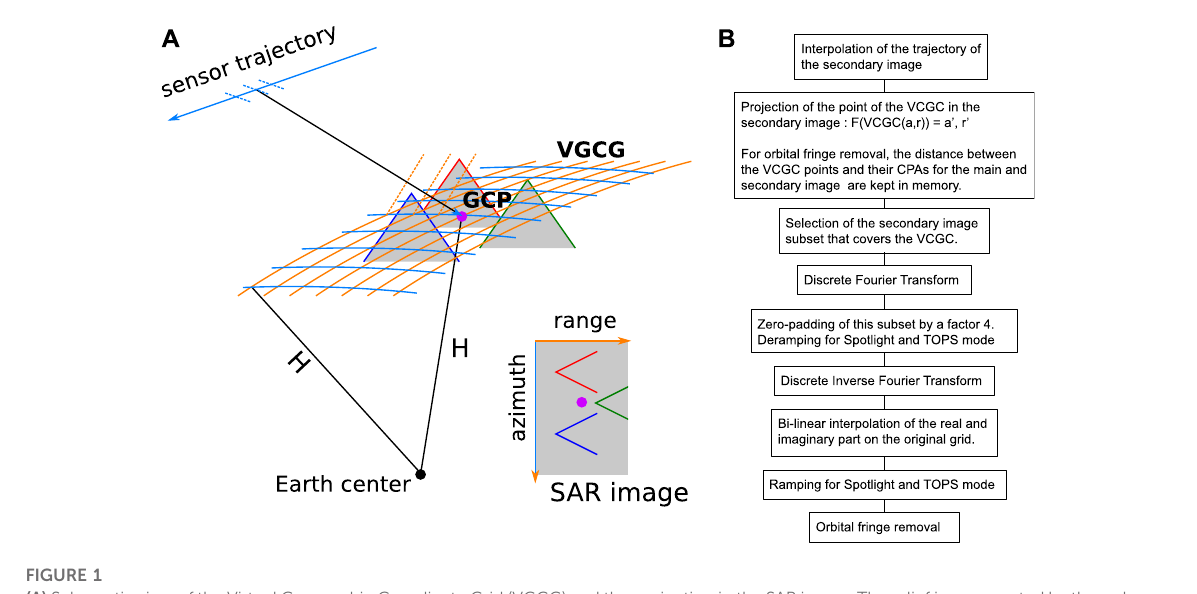
FIGURE 1 (A) Schematic view of the Virtual Geographic Coordinate Grid (VGCG) and the projection in the SAR image. The relief is represented by the red, green, and bluemountains. The ground control point (GCP) isrepresented inviolet. Itis atthecenter oftheresampledSARimagesubset. The VGCG is constructed on a sphere, centered on the Earth center and whose radius is the distance between the GCP and the Earth center. The grid itself is de fi ned by the range lines in orange, parallel to the sensor trajectory and spaced by the ground range sampling, and the azimuth lines in light blue, parallel to the ground range direction and spaced by the azimuth sampling. (B) LabSAR coregistration processing